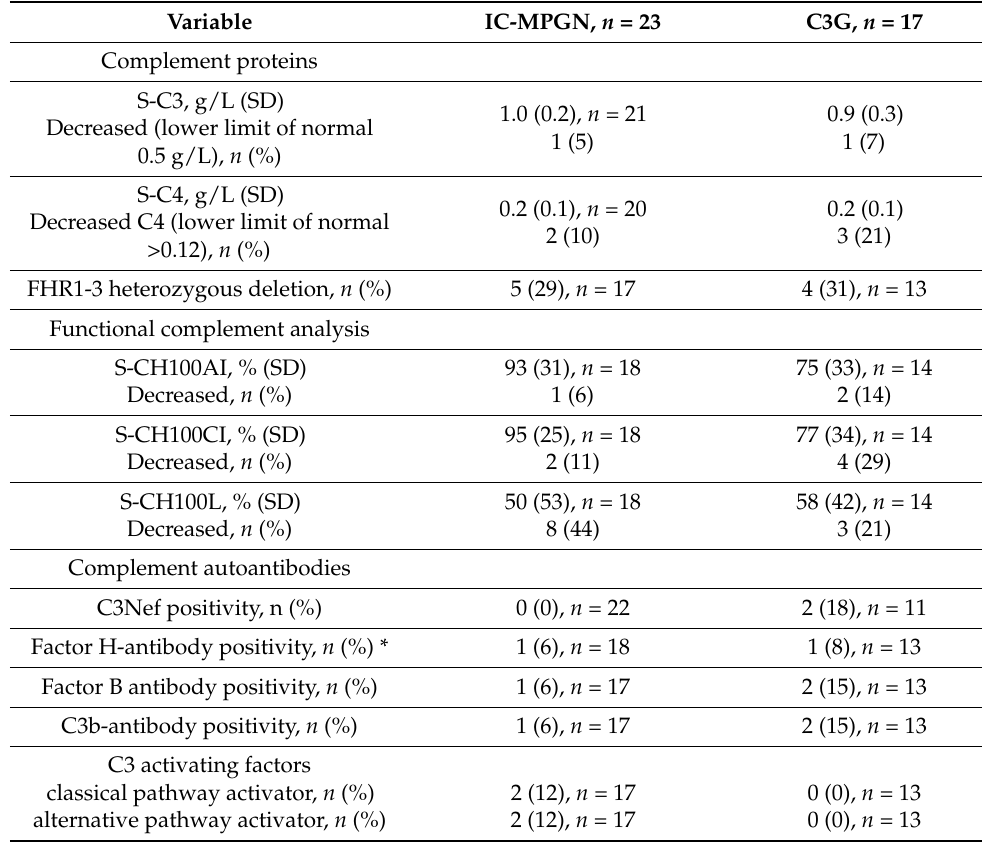
Figure 3. Different morphological features were observed on light microscopy (LM) in IC-MPGN and C3G patients. Differences in subcategory division between the patient groups were not significant Figure 3. Di ff erent morphological features were observed on light microscopy (LM) in IC-MPGN ( p > 0.05 for comparisons). and C3G patients. Di ff erences in subcategory division between the patient groups were not signi fi - cant ( p > 0.05 for comparisons). Table 4. Complement and paraprotein characteristics during the last outpatient visit. Values are expressed as means (SD) or numbers (percentage) of patients. The number of patients signifies the maximum number of patients with the information. Unless otherwise indicated, the variable numbers were available for all patients. None of the differences between the groups were significant ( p > 0.05 for all